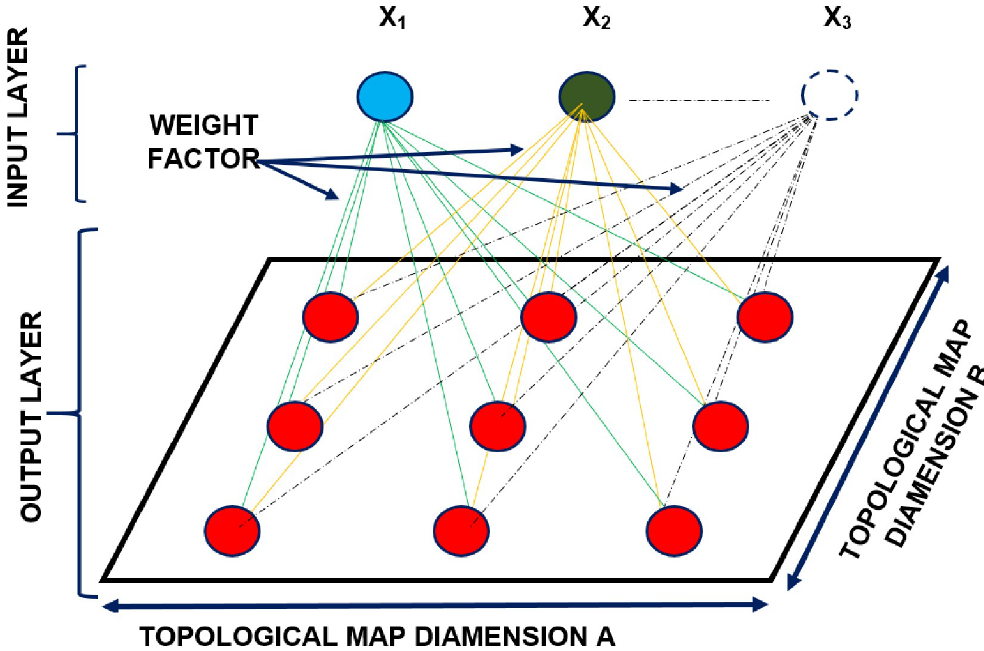
Fig 2. Kohonen’s neural network